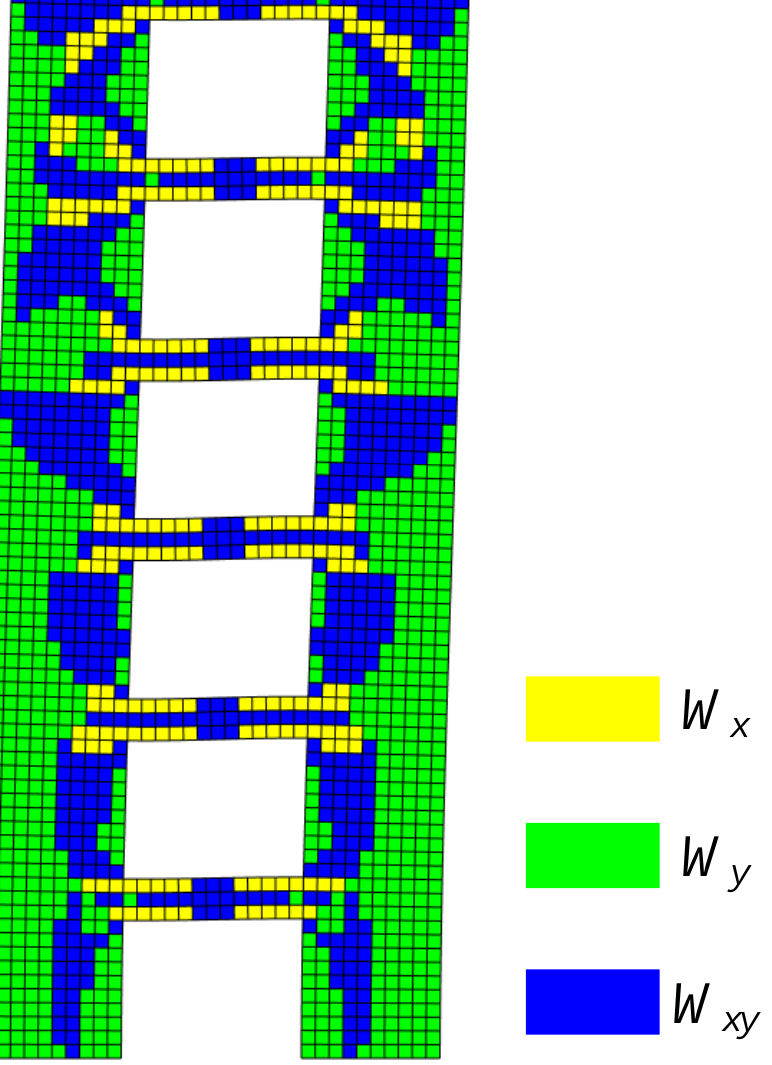
Figure 10. Modal strain energy decomposition diagram of first-order vibration mode.